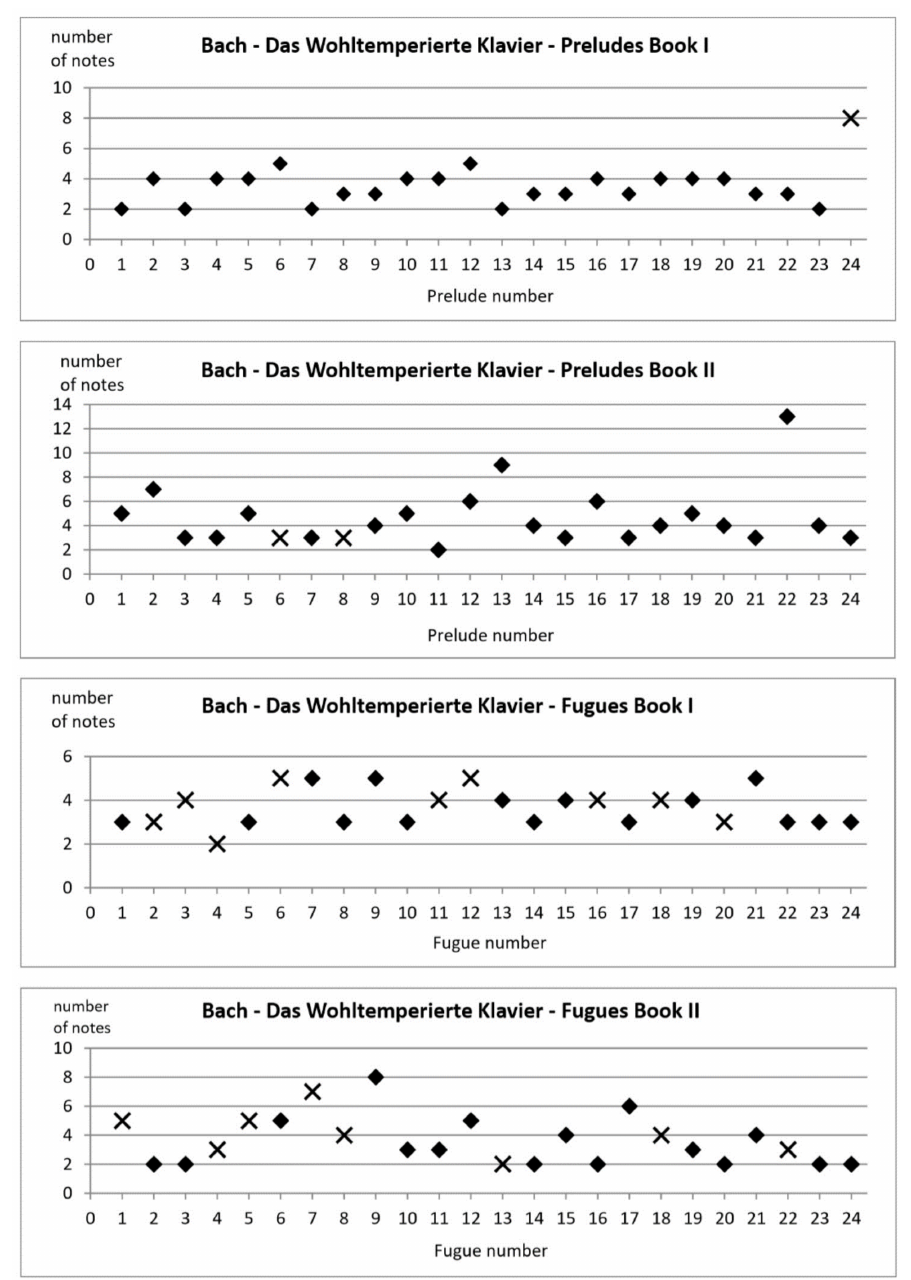
Figure 6. The number of notes needed to determine the key signatures of the analyzed fragments of music by J.S. Bach: (cid:7) —correct recognition of the key signature; x—incorrect recognition of the key